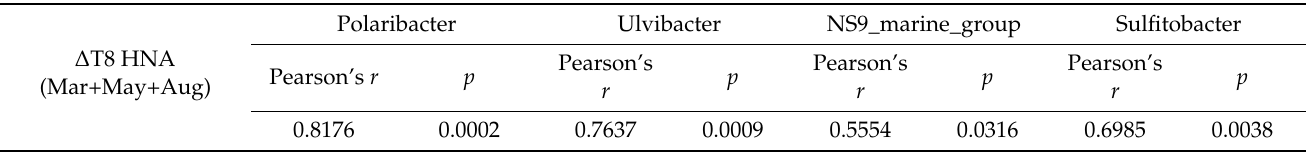
Figure A5. Correlations between the HNF and bacteria in the August experiment for fractions <10 µ m and <90 µ m. ( a ) No correlation ( p = 0.0727) in the <10- µ m fraction and no correlation ( p = 0.2635) in the <90- µ m fraction for HNF against the total bacteria and ( b ) a weak correlation ( p = 0.045) in the <10- µ m fraction and no correlation ( p = 0.6134) in the <90- µ m fraction for HNF against the proportion of HNA to LNA bacteria. Table A1. Correlation of the changes of HNA abundances from the experiments caried out in March, May and August and the relative abundances of members of the bacterial community.